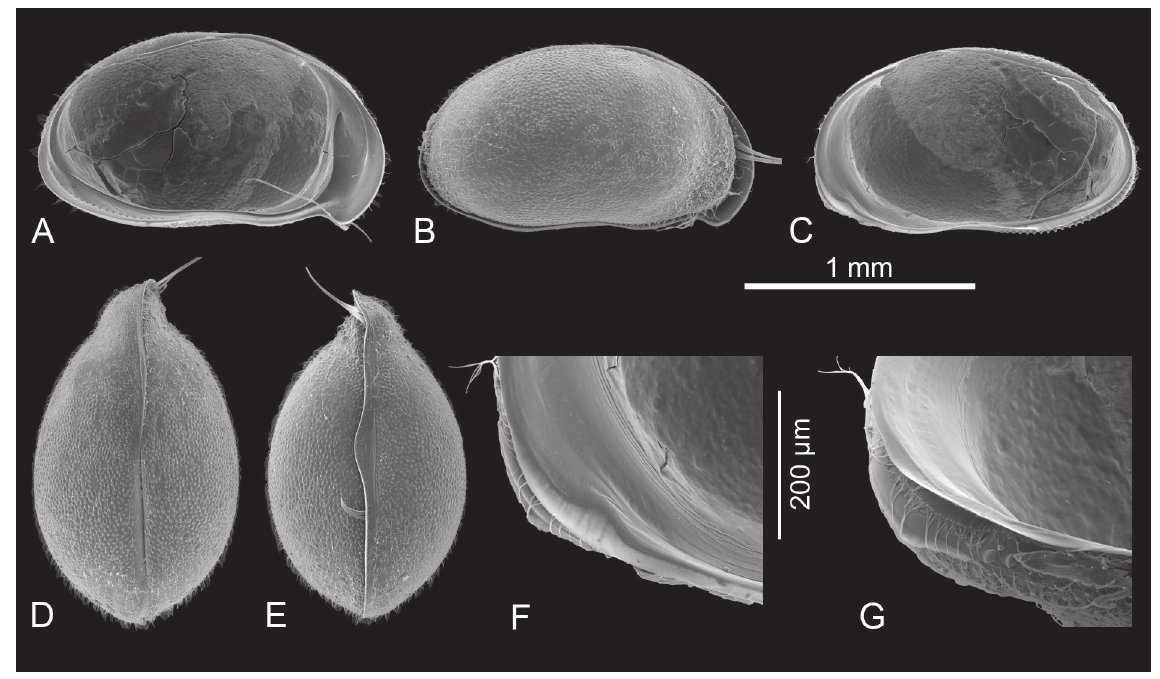
Fig. 8. Bennelongia pinderi sp. nov. (all ♀, all from type locality: unnamed claypan in Murchison/ Gascoyne, WA). A . LVi (holotype, WAMC55620). B . CpRL (WAMC55622). C . RVi (WAMC55620). D . CpD (WAMC55621). E . CpV (OC3378). F . RVi, detail anterior margin (WAMC55620). G . rVi, tilted, detail anterior margin (WAMC55620). Scale = 1 mm for A–E; 200 µm for